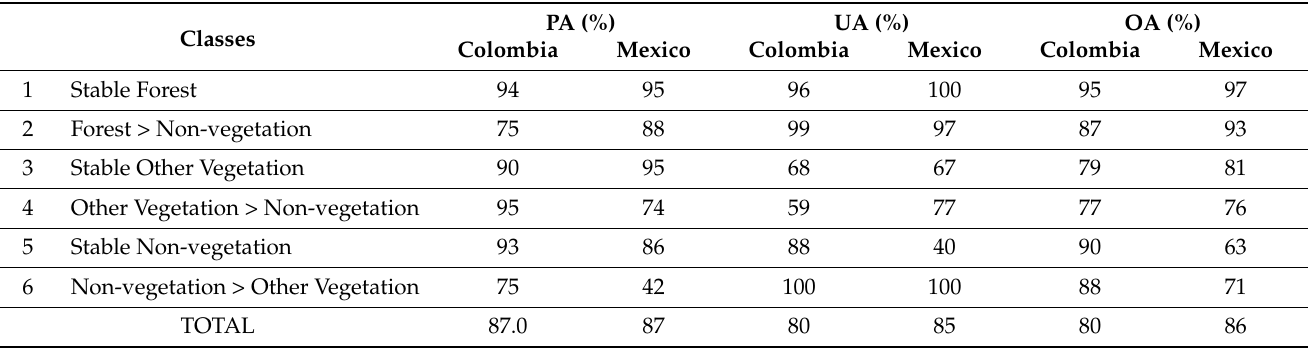
Table 3. The accuracy assessment of the change detections from Sentinel-2 by the visual interpretation of PlanetScope data for the two window areas. NRT: near real-time; PA: producer accuracy; UA: user accuracy; OA: overall